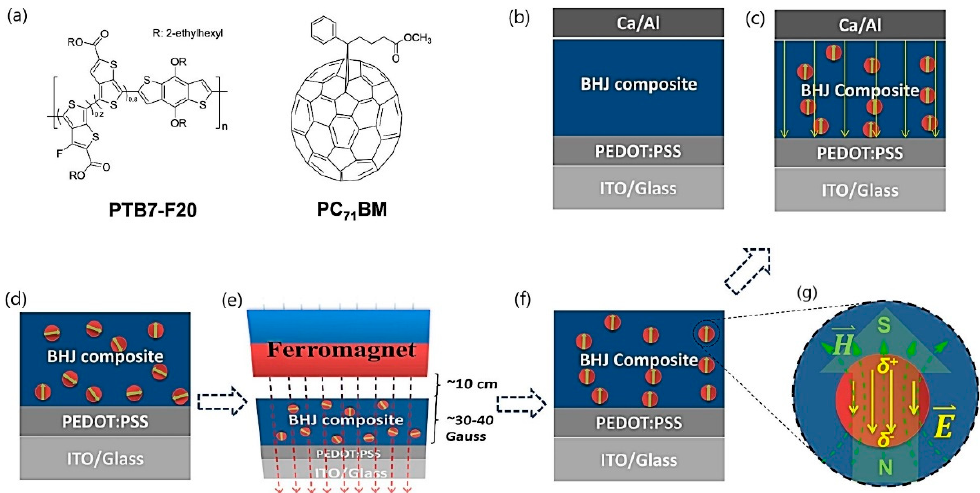
Figure 19. The molecular structures of PTB7-F20 and PC71BM ( a ); the conventional device structure of PSCs without incorporating any Fe 3 O 4 magnetic nanoparticles (MNPs) ( b ); the conventional device structure of PSCs incorporated with Fe 3 O 4 MNPs and aligned by an external magnetostatic field ( c ); the fabrication procedures of PSCs incorporated with Fe 3 O 4 MNPs and aligned by an external magnetostatic field ( d )–( f ); BHJ active layer incorporated with Fe 3 O 4 MNPs was spin-coated on a PEDOT:PSS-coated ITO substrate ( d ); and a ferromagnet was suspend above the surface of BHJ composite incorporated with the Fe 3 O 4 MNP layer. The magnetic intensity was ~30–40 G, and the distance between the ferromagnet and BHJ composite layer was ~10 cm ( e ); oriented Fe 3 O 4 MNPs inside BHJ active layer by an external magnetostatic field. In pre-devices ( f ), a drawing of a partial enlargement of the Fe 3 O 4 MNP in ( c ), showing an antiparallel relation between the magnetic dipole (caused by the Fe 3 O 4 crystal inside the particle) and electric dipole (caused by the difference in charge density between the inside Fe 3 O 4 and outside organic coater) ( g ) (adapted from [132] with permission from Scientific Reports).